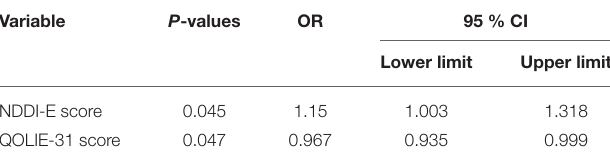
TABLE 4 | Logistic regression analysis of the associations of social isolation.